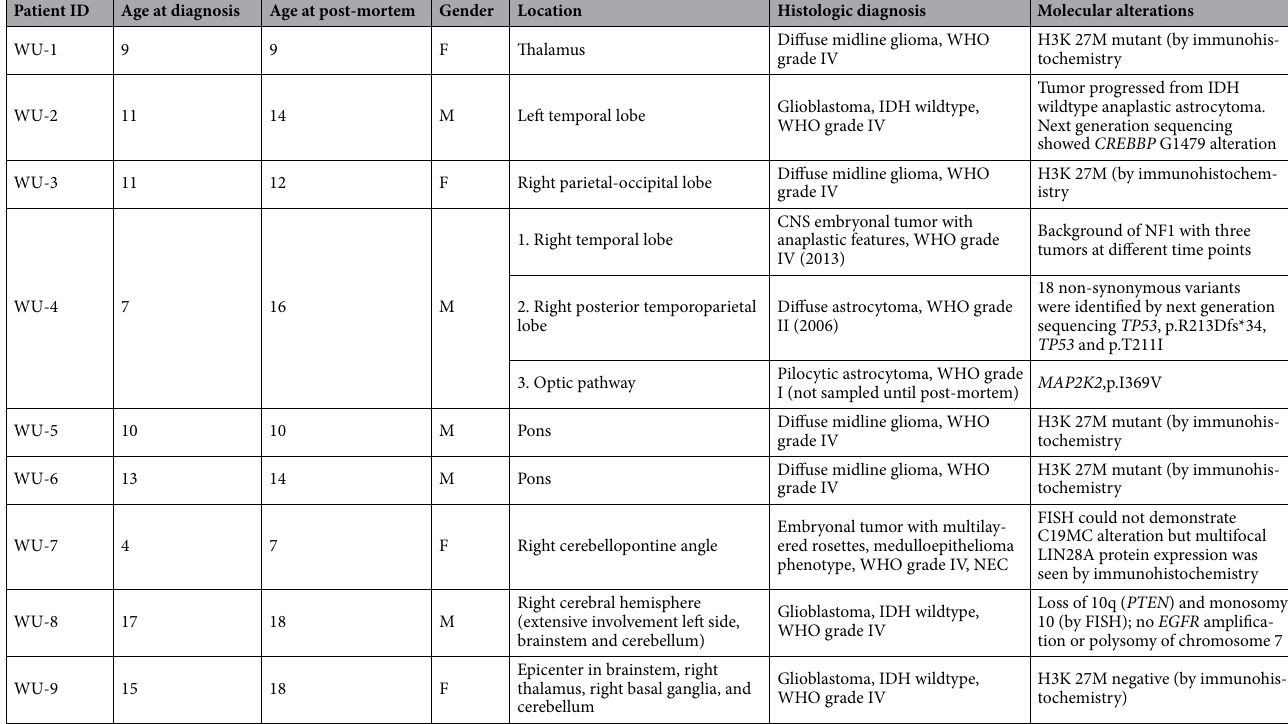
Table 1. Patient information.